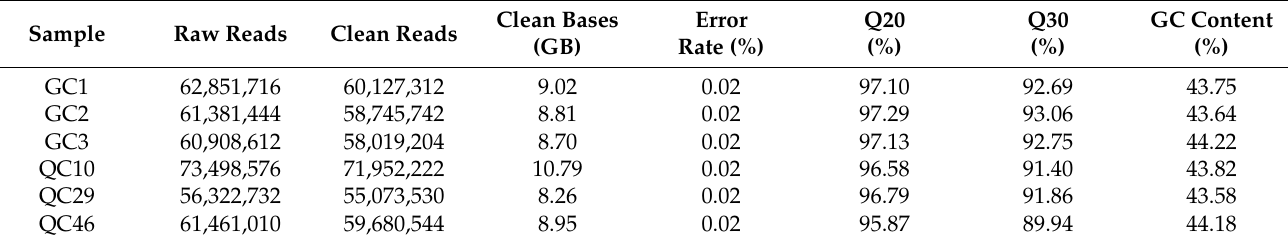
Table 1. Summary of transcriptome data of S. obtusifolia seeds.